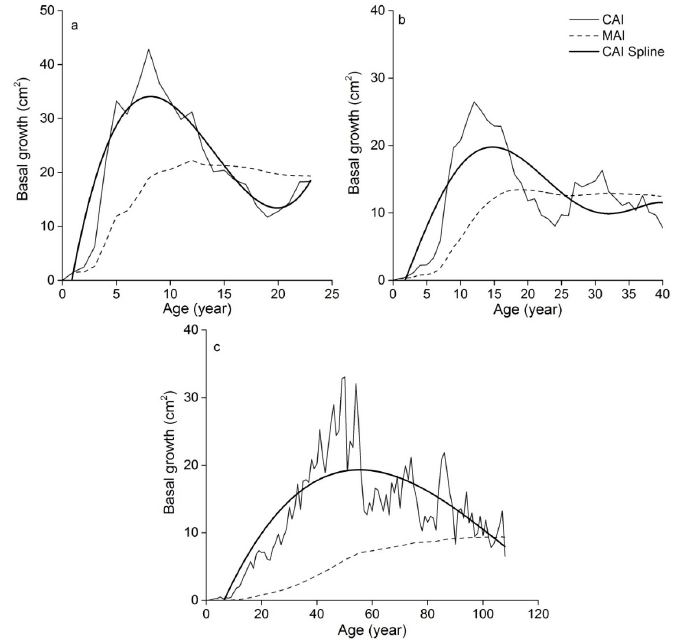
Figure 4. Current (CAI) and mean (MAI) annual basal area increments in relation to tree ages for the Chinese fir in the burning ( a ), clearing ( b ) and natural forest ( c ). In contrast to other types of site preparation, the growth rate of Chinese fir in the controlled burning site during the juvenile stages was significantly high, with an average increment of 1.5 cm slow compared to that of the burning site. In the planted sites, the MAI was 3.03 cm 2 for the brush